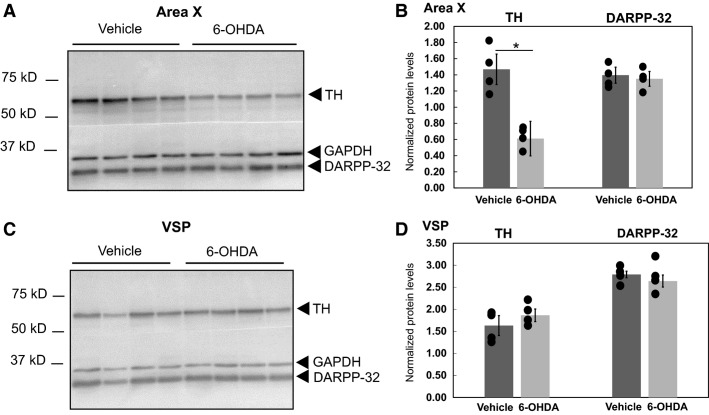
6-OHDA reduces TH signal in Area X but not VSP. (A–B) Immunoblot (A, left; 15 μg/lane) shows decreased TH signal in 6-OHDA- versus vehicle-injected birds, as quantified in the accompanying graph (B, right). No change in DARPP-32 signal was detected. Quantification shows means (bars), standard error (plungers), and individual bird values (circles). (C–D) Immunoblot (C, left; 15 μg/lane) with accompanying graph (D, right) indicates no change in TH and DARPP-32 signals in the VSP for the same birds as in A–B.